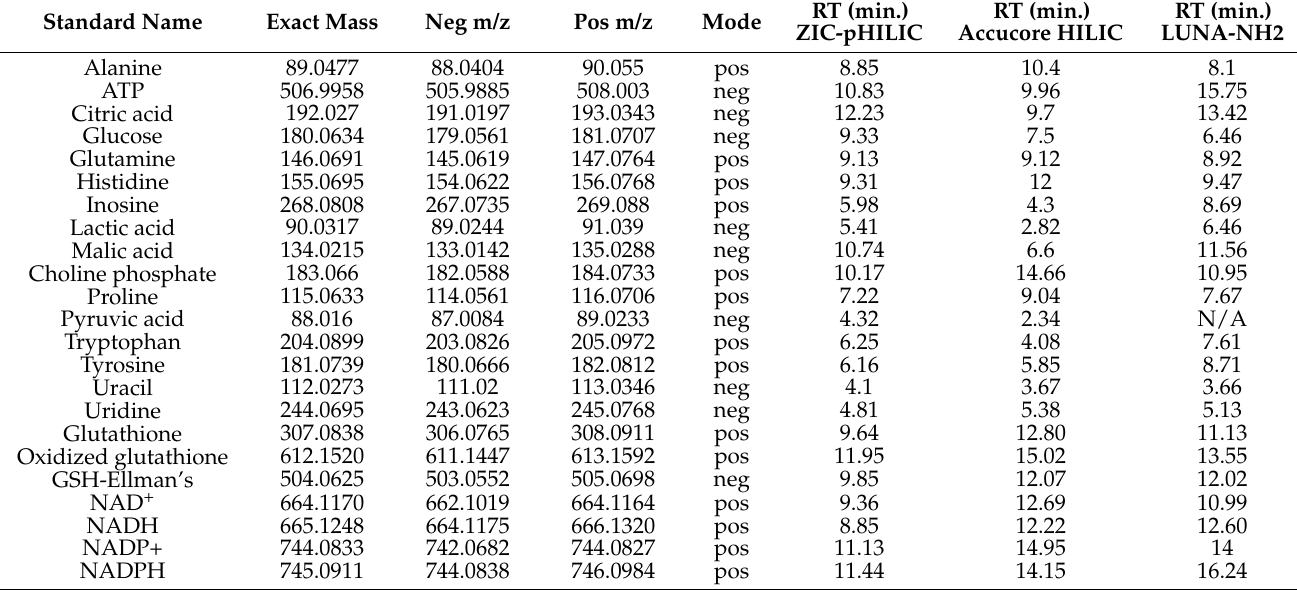
Table 1. Retention times and HESI polarity mode for metabolite standards shown in Figure 1. Three chromatographic column separations are indicated. A full list of characterized metabolites can be found in Table